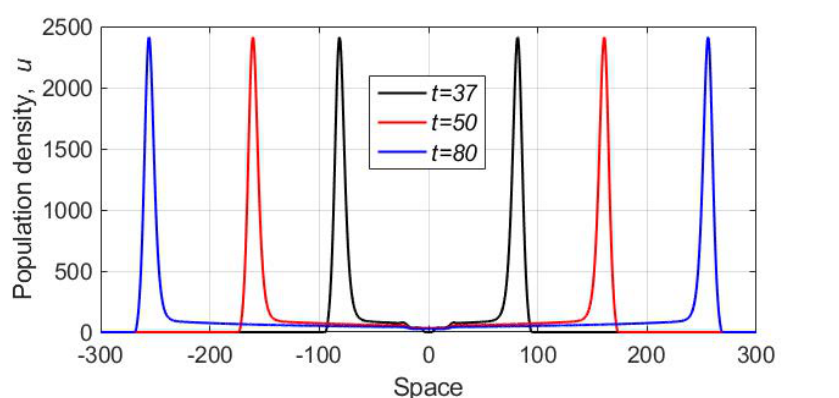
Figure 8. Population density vs. space obtained as a solution of Model (12) and (13) shown at different moments of time. Parameters are (cid:101) 0 = 0, (cid:101) = 1, a = 115, h = 20, β = 0.00025, D = 1, and D m = 0.1.